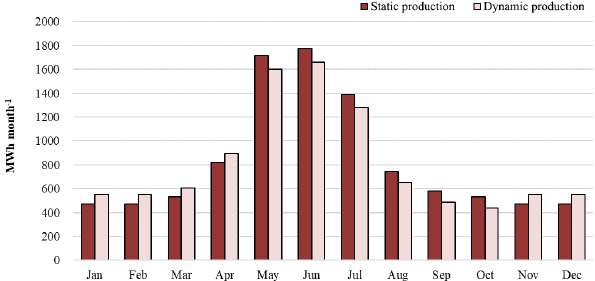
Figure 8. Monthly electricity consumption for supplying water by static and dynamic production of phosphate slurries transported by